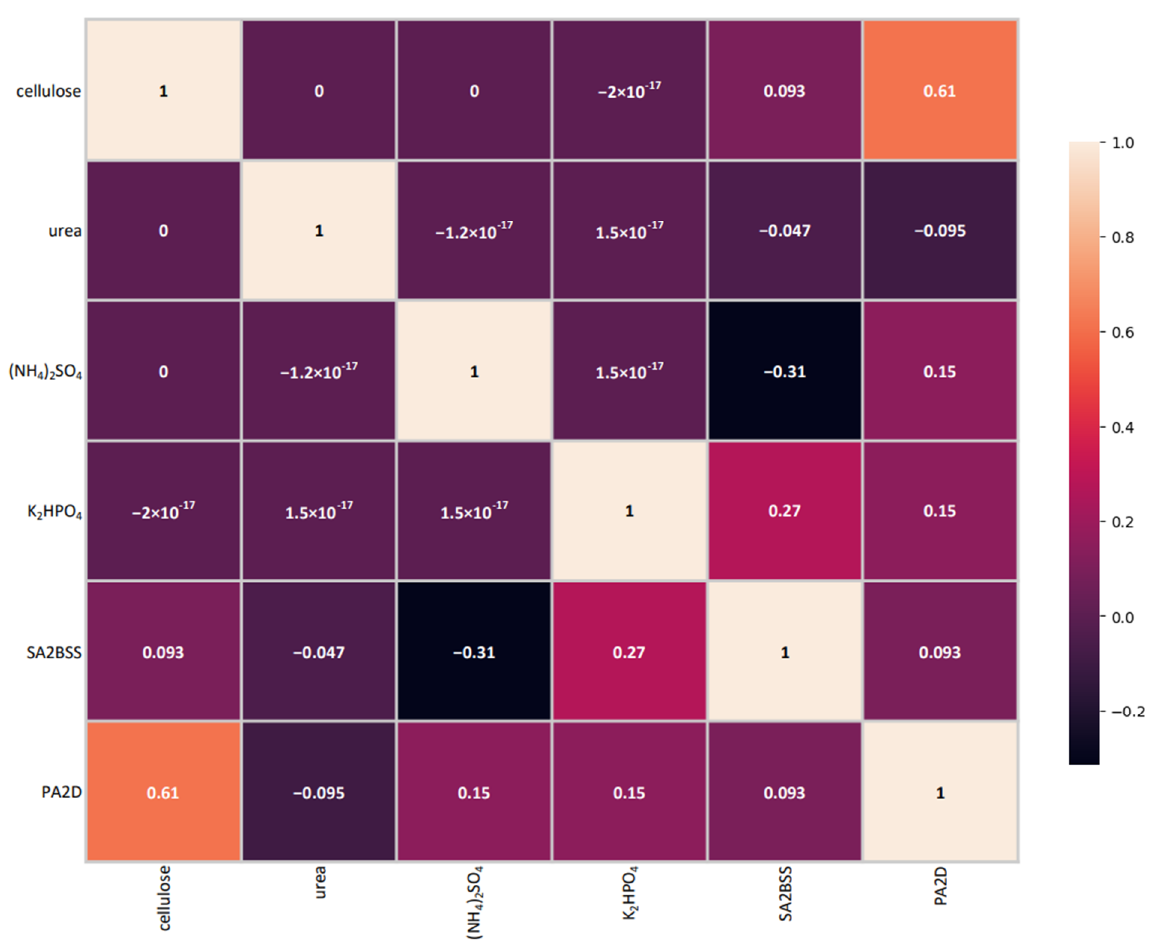
Figure 1. Correlation matrix of the experimental values used in the medium composition